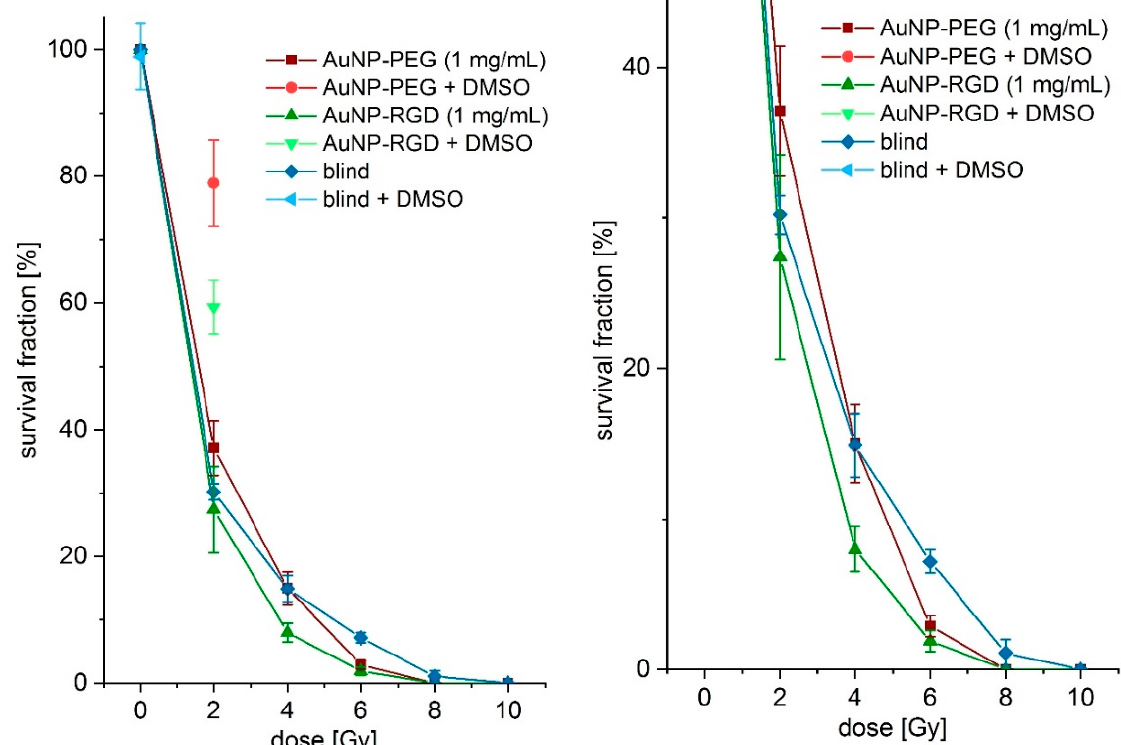
Figure A22. Colony formation assay with survival fraction 0–105% linear ( left ) and zoom 0–45% linear ( right ).